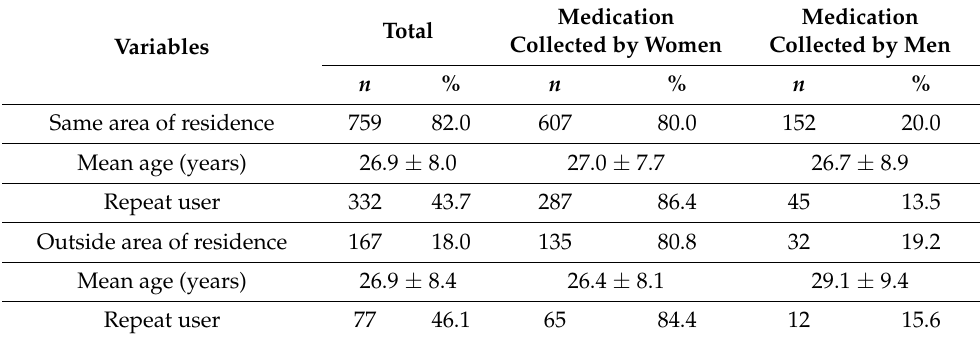
Table 2. Profile and behavior of users who used EC according to their area of residence.